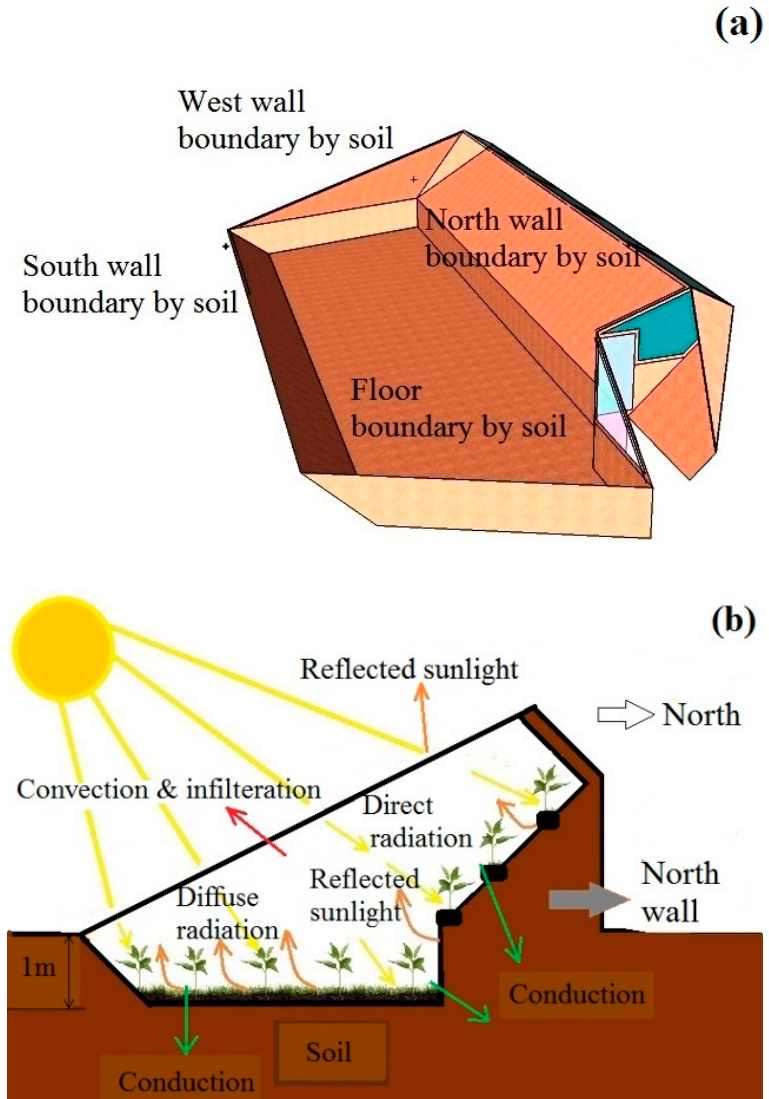
Figure 2. The part of walls that are composed of soil in 3-D ( a ) and 2-D ( b ).